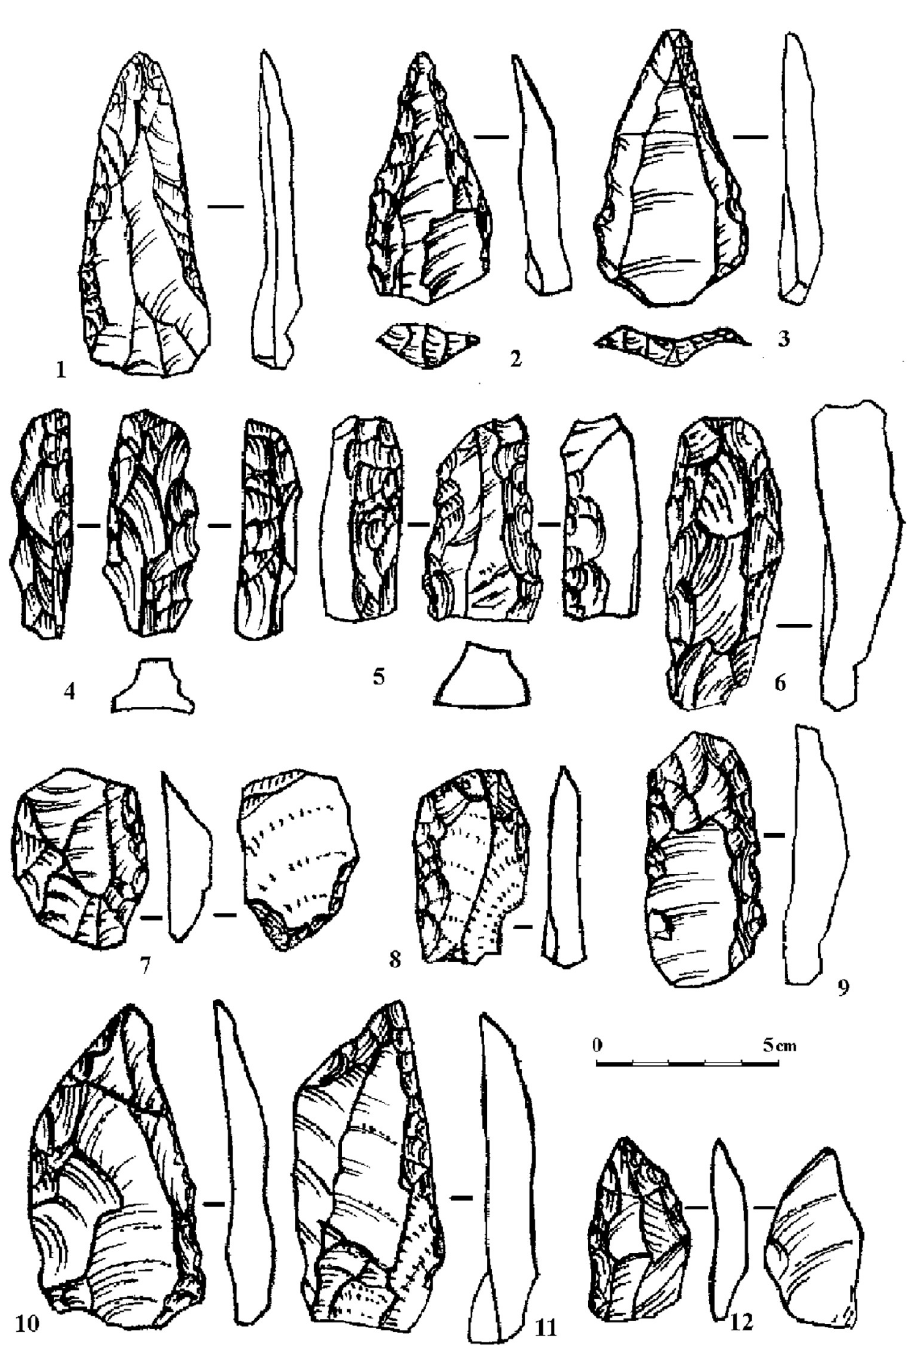
Fig 6. Weasel cave. The retouched tools typical of the Zagros Mousterian industry. 1, 2 –elongated Mousterian points; 3 –Levallois retouched point; 4–6 –thick double scrapers; 7 –truncated-faceted scraper; 8, 9 –side-scrapers; 10, 11 – side-scrapers made on Levallois blades; 12 – déjeté scraper. Modified from [8: fig 10].